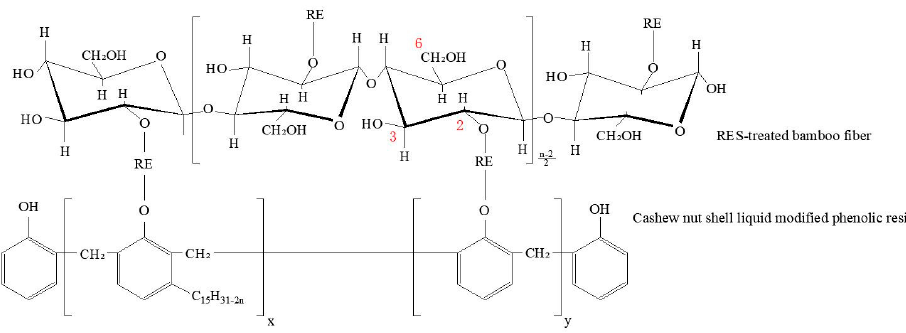
Figure 13. Mechanism of the improvement of interfacial adhesion between BF and the resin matrix by the RES modification.